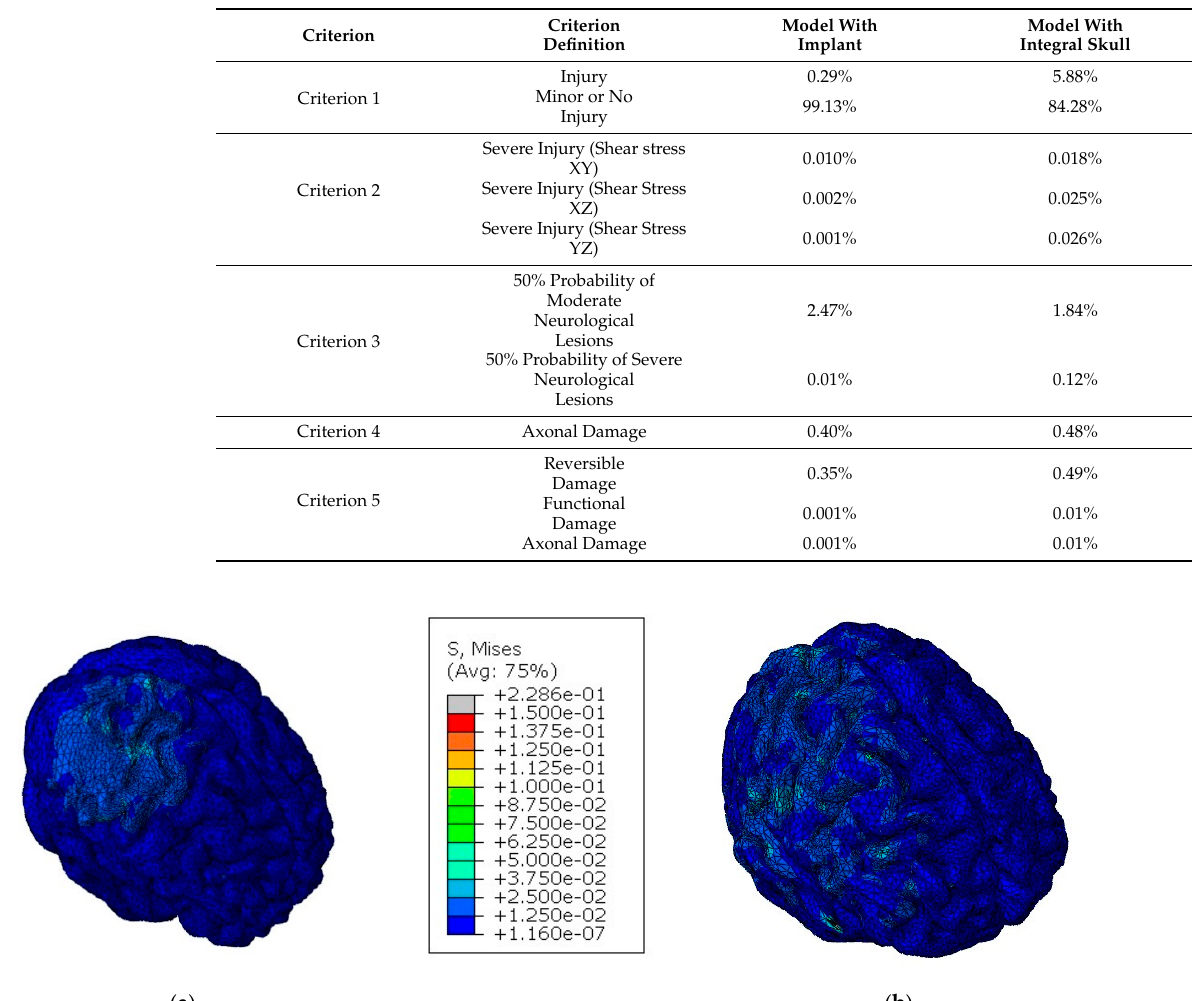
Table 4. Percentage of brain tissue within the thresholds that match the criteria defined.